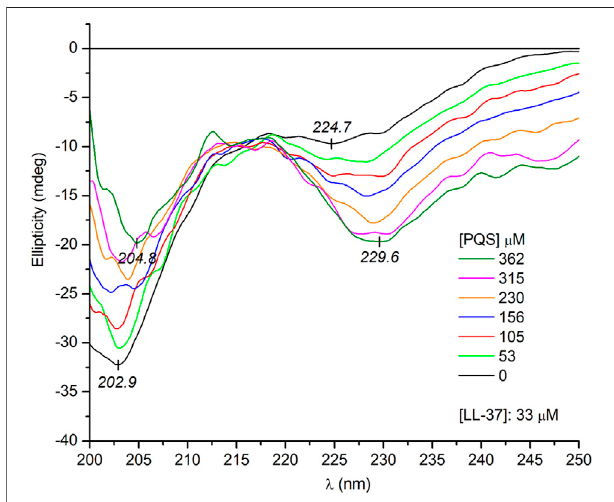
FIGURE 6 | Far-UV CD spectra of LL-37 at increasing PQS concentrations recorded inasalt-free Tris-HCl buffer solution(the opticalpath length is 0.2